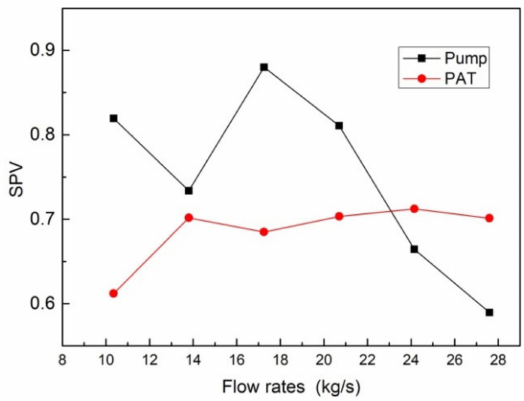
Figure 6. SPV variation at different flow rates of the pump and